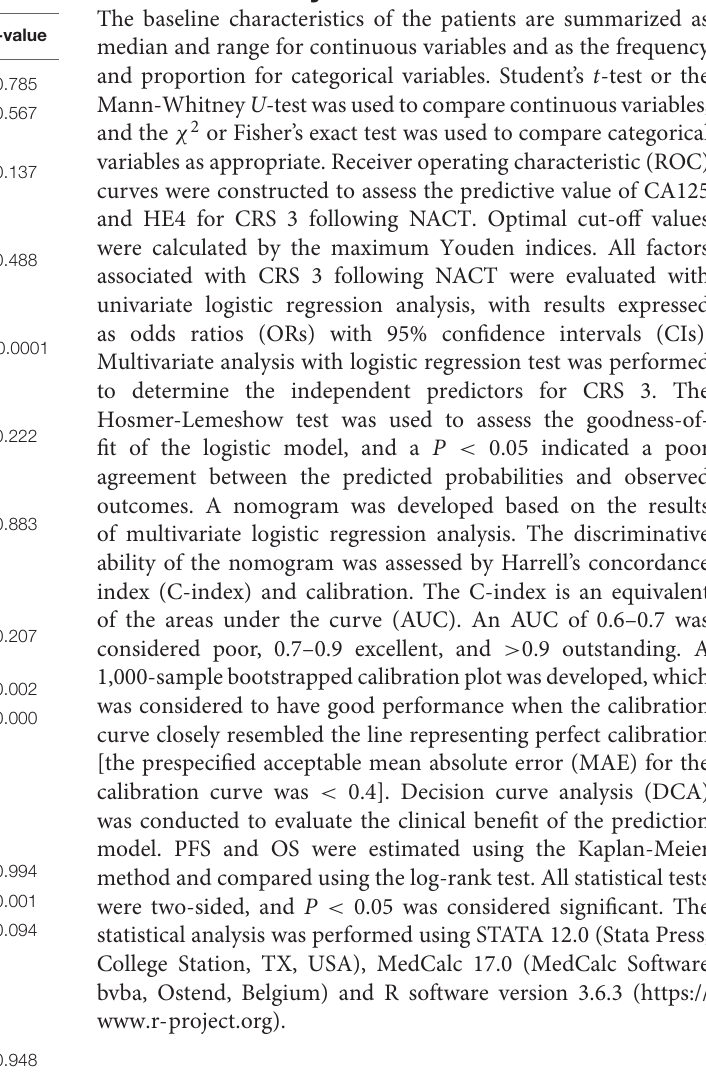
TABLE 1 | Characteristics of